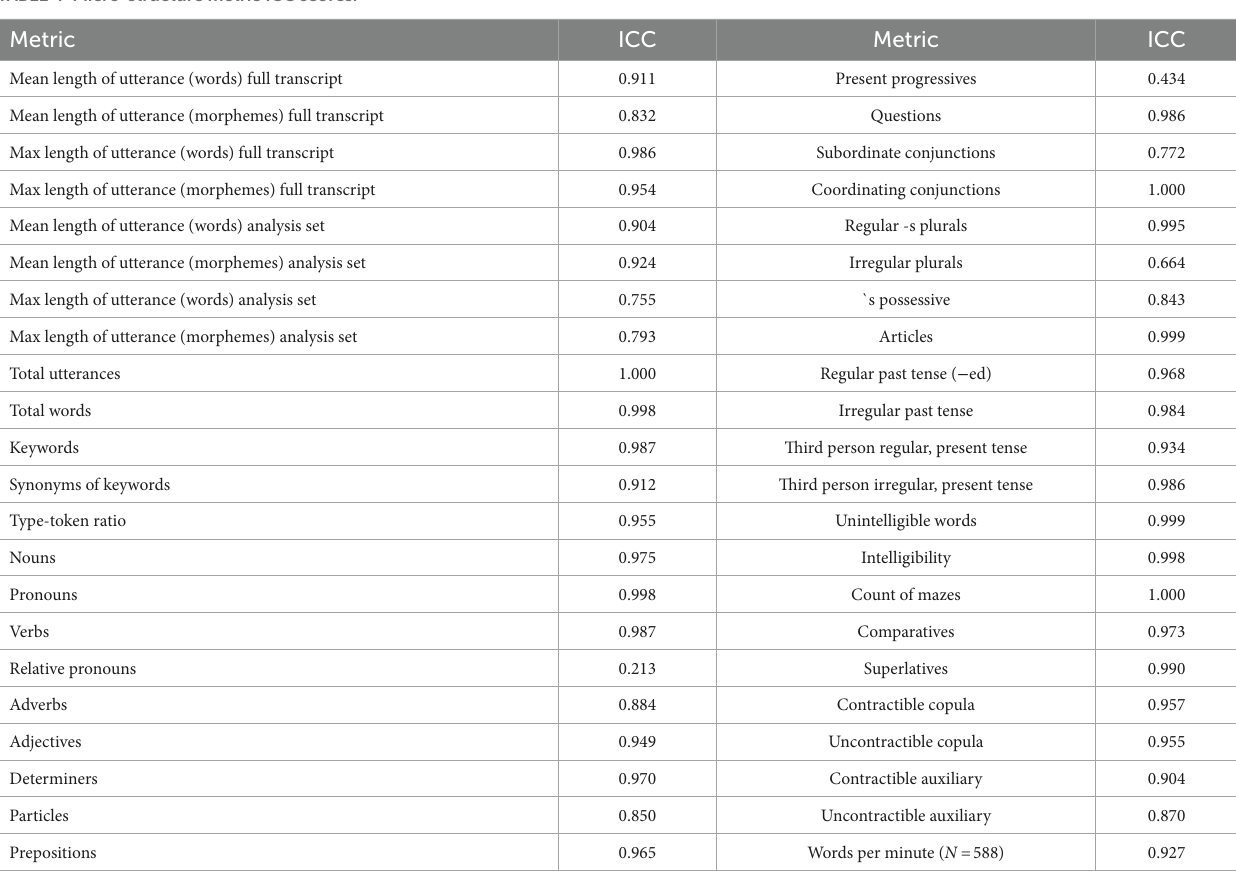
TABLE 4 Micro-structure metric ICC